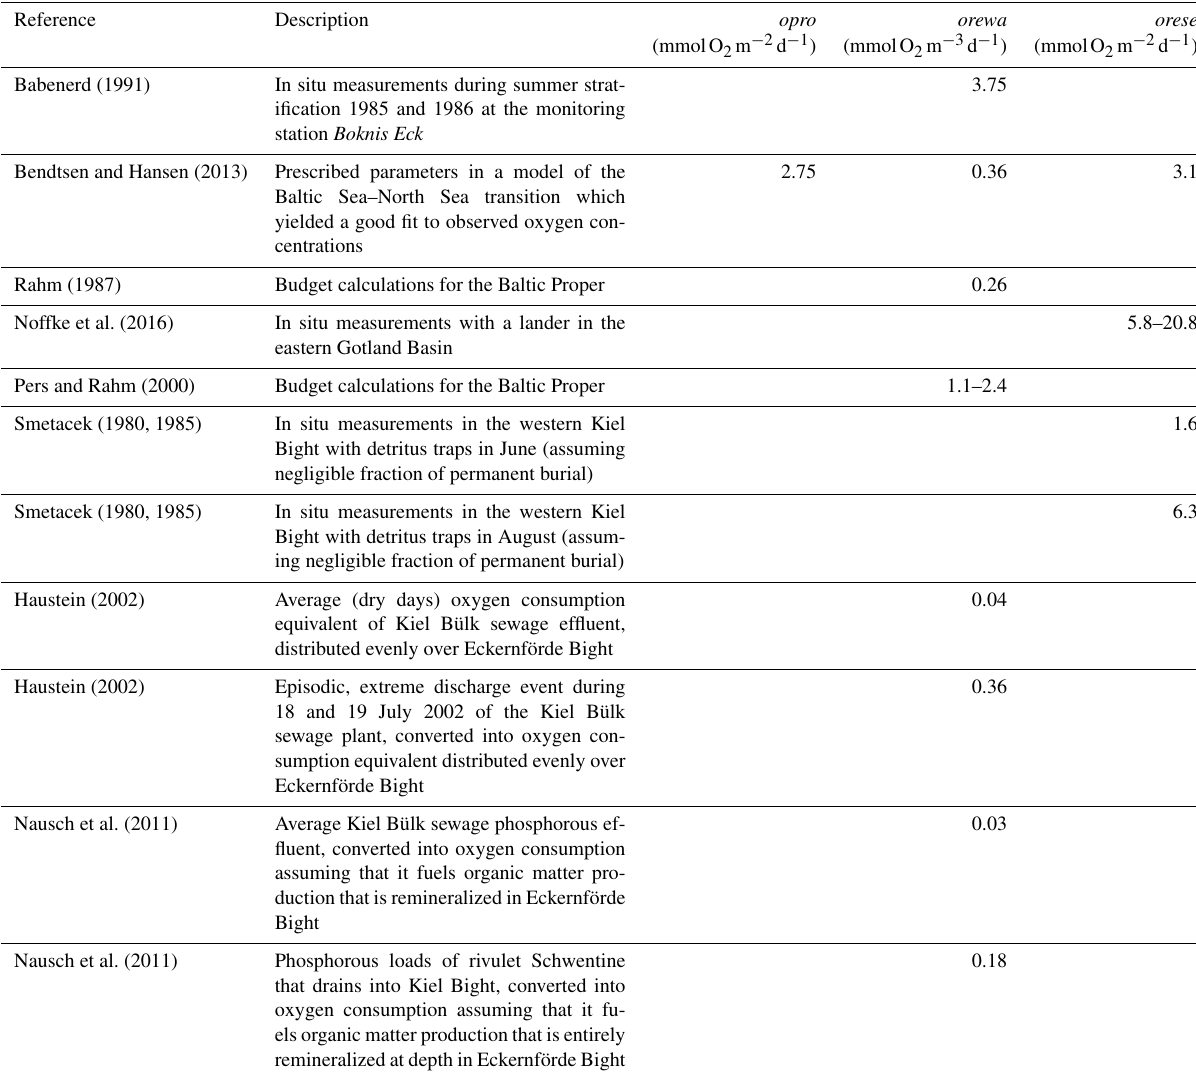
Table 1. Estimates of oxygen consumption and production converted to respective model parameters of the EckO 2 module. Conversions may include division by the average water depth and area of Eckernförde Bight (see Sect. 2.1.1), a O 2 : C ratio of 1.1, and a C : P ratio of